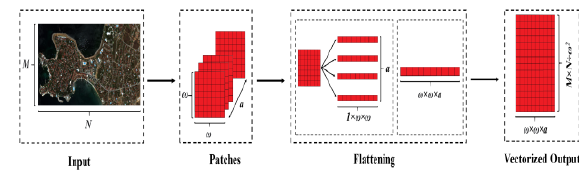
Figure 2. Creation of vectorized input from MS raster image In the second step of patch-based classification, training and test samples were separately created from all Datasets. Training